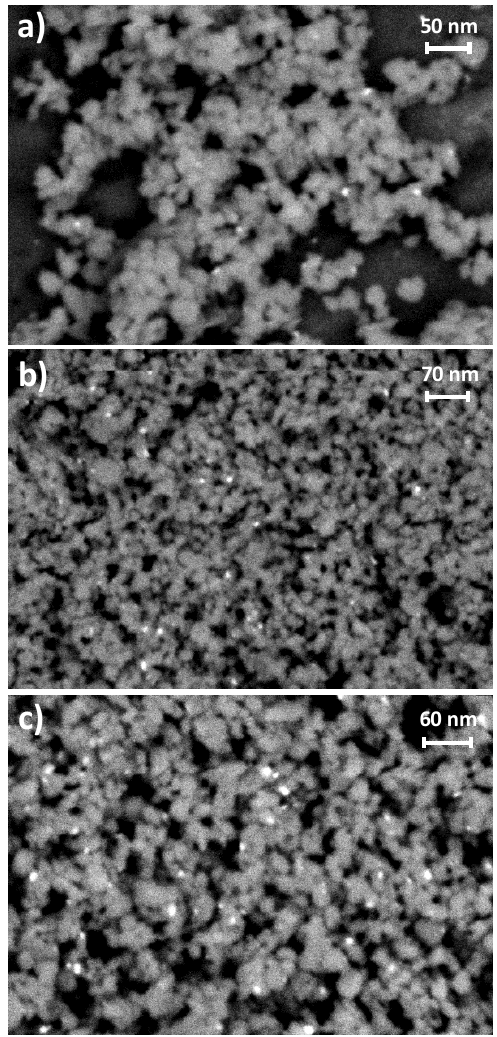
Figure 4. Z-contrast micrographs obtained by high-resolution field emission scanning electron microscopy (HRFESEM) using an energy selective backscattered (EsB) electron in-lens detector for the Fe 3 O 4 -based catalysts doped with 1% Pd ( a ), 2% Pd ( b ), and 3% Pd ( c ).